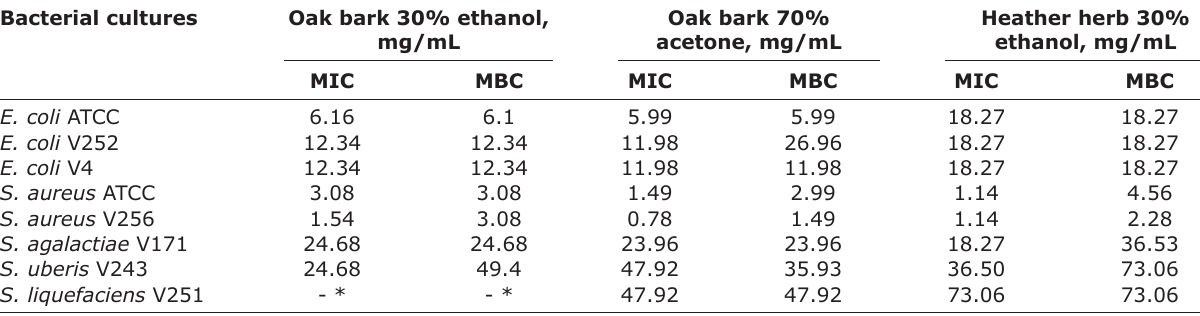
Table-3: MIC and MBC of oak bark extracts and heather extract. Bacterial cultures Oak bark 30% ethanol,